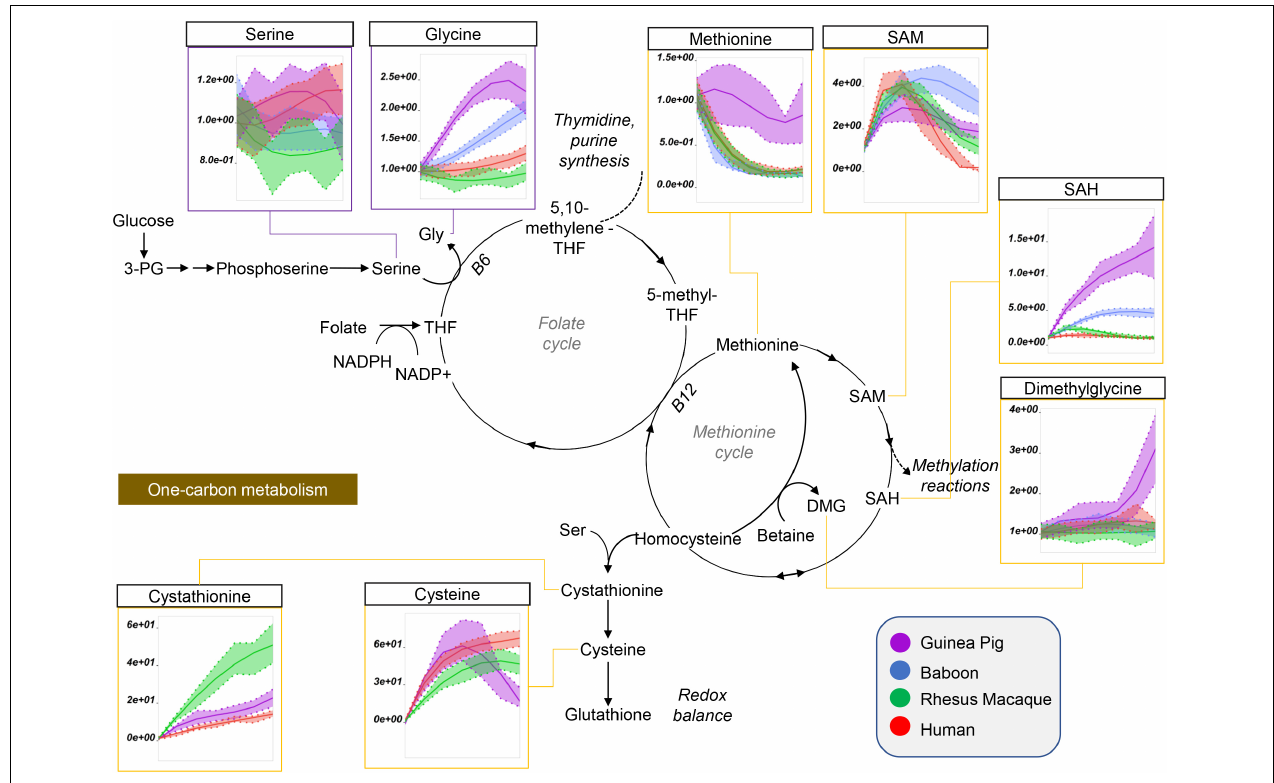
FIGURE 5 | Impact of storage on methionine and one-carbon metabolites in RBCs from guinea pigs (violet), baboons (blue), rhesus macaques (green), and humans (red). Line plots indicate metabolite medians (lighter colored areas are ranges) normalized to measurements in fresh, non-stored blood (day 0) and autoscale normalized across groups. All metabolites are significant by ANOVA (FDR corrected– p <